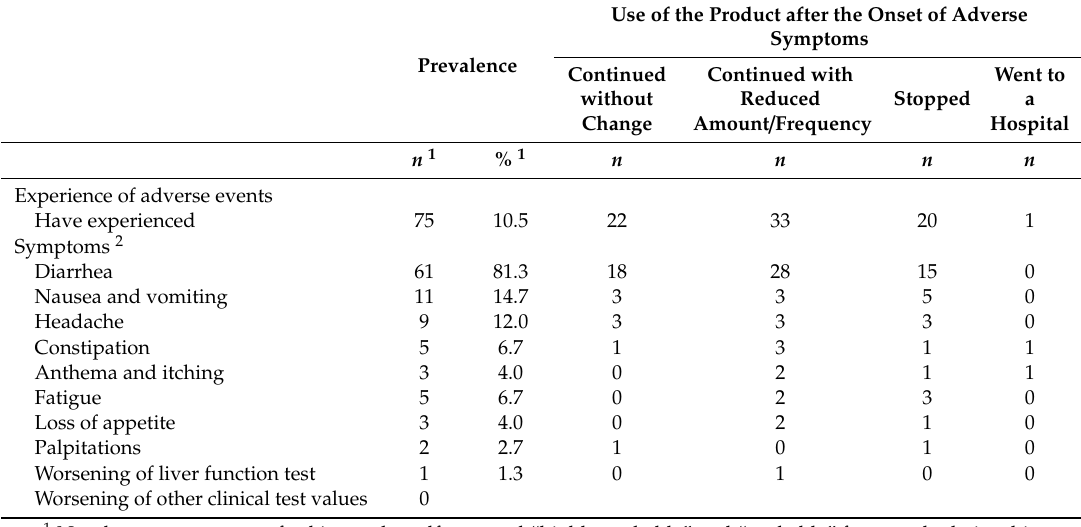
Table 2. The prevalence of adverse events among all subjects ( n = 715) and the use of the Coleus forskohlii product after the onset of adverse symptoms.